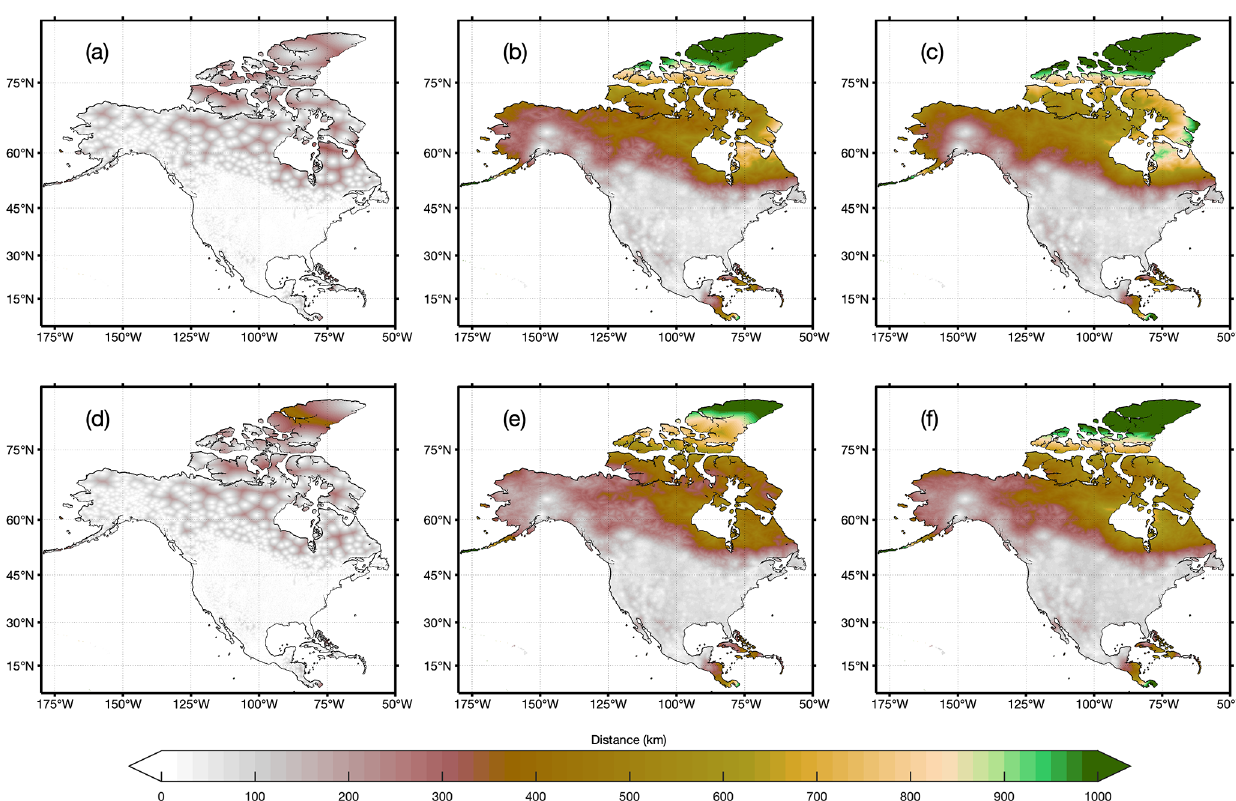
Figure 1. The color of each 0.1 ◦ grid indicates the radius to find (a) 1, (b) 20, and (c) 30 neighboring stations for precipitation (a–c) and temperature (d–f)